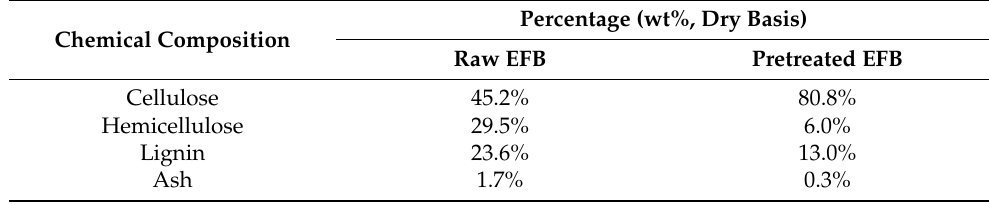
Table 2. Overall Mass Balance Summaries at a 30% EFB Splitting Ratio to Pellet Production [74,80]. Chemical